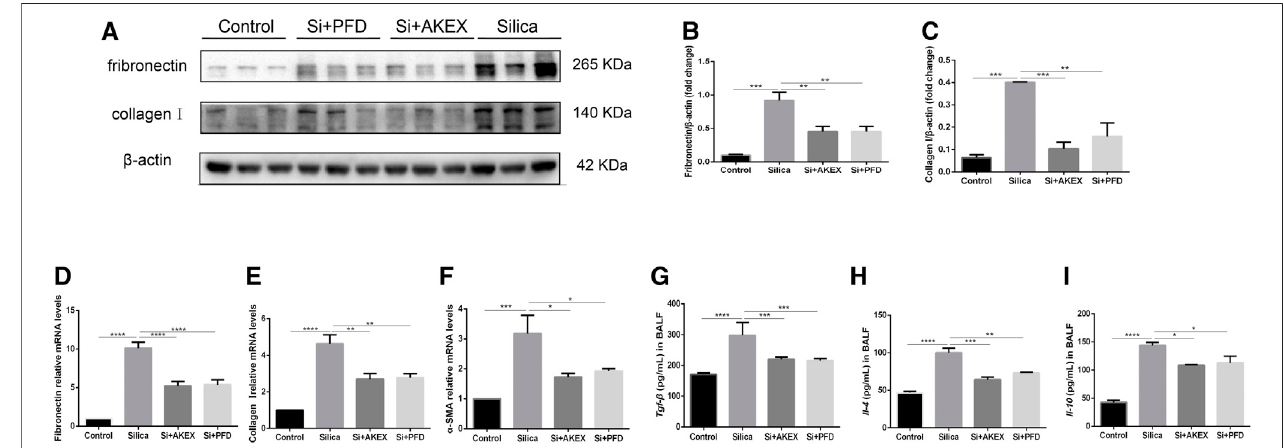
FIGURE 4 | AKEX0011 ameliorated pulmonary fi brosis in the early therapeutic silicosis model. (A) WB of fi bronectin and collagen I. β -actin was used as a loading control. (B,C) Quanti fi cation ofband densitiesfrom images in (A). (D-F) mRNA levels of fi bronectin, collagen I, and α -SMA inlung tissueswere detected byqPCR(n =5). (G-I) TGF- β , IL-4, and IL-10 in the BALF detected by ELISA (n = 3-5). All data were presented as mean ± SEM; * p < 0.05, ** p < 0.01, *** p < 0.001, and **** p < 0.0001.